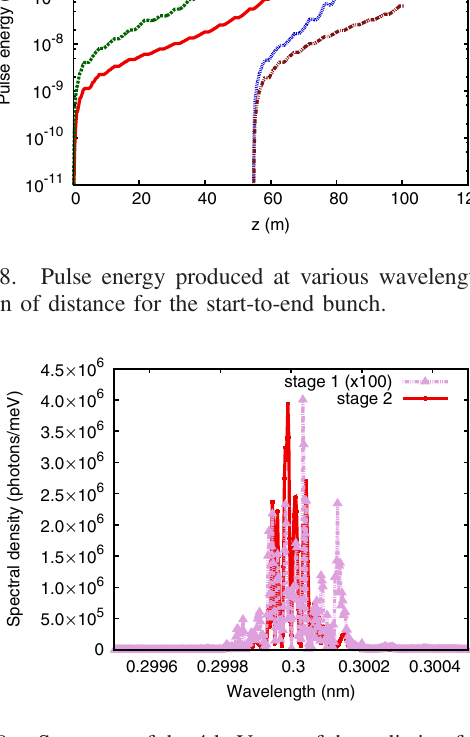
FIG. 19. Spectrum of the 4 keV part of the radiation for at end of stage 1 (scaled up by a factor of 100) and at the end of stage 2 for the start-to-end